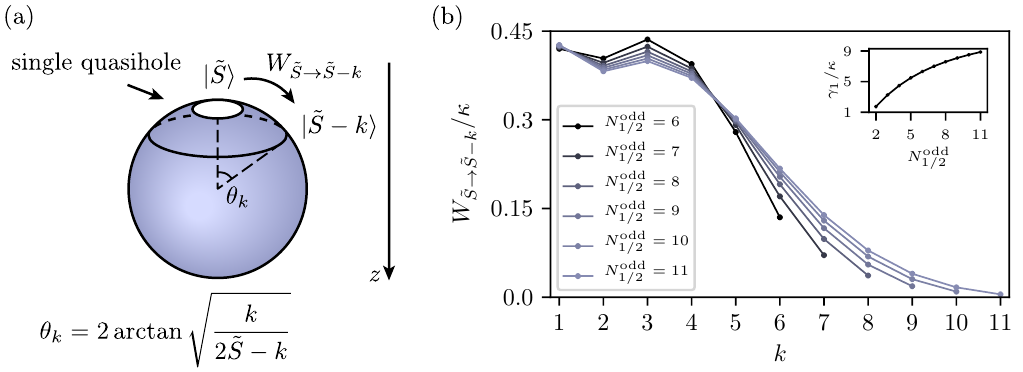
Figure 3: Dynamics of a single quasihole in a stabilized Laughlin state on a sphere ( ν = 1 / 2). The sphere is pierced by an odd number of magnetic flux quanta, N φ , such that the quasihole is unpaired and cannot be refilled by the stabilization setup. The Hilbert space for the quasihole is formally equivalent to that of a spin ˜ S = ( N φ + 1 ) /